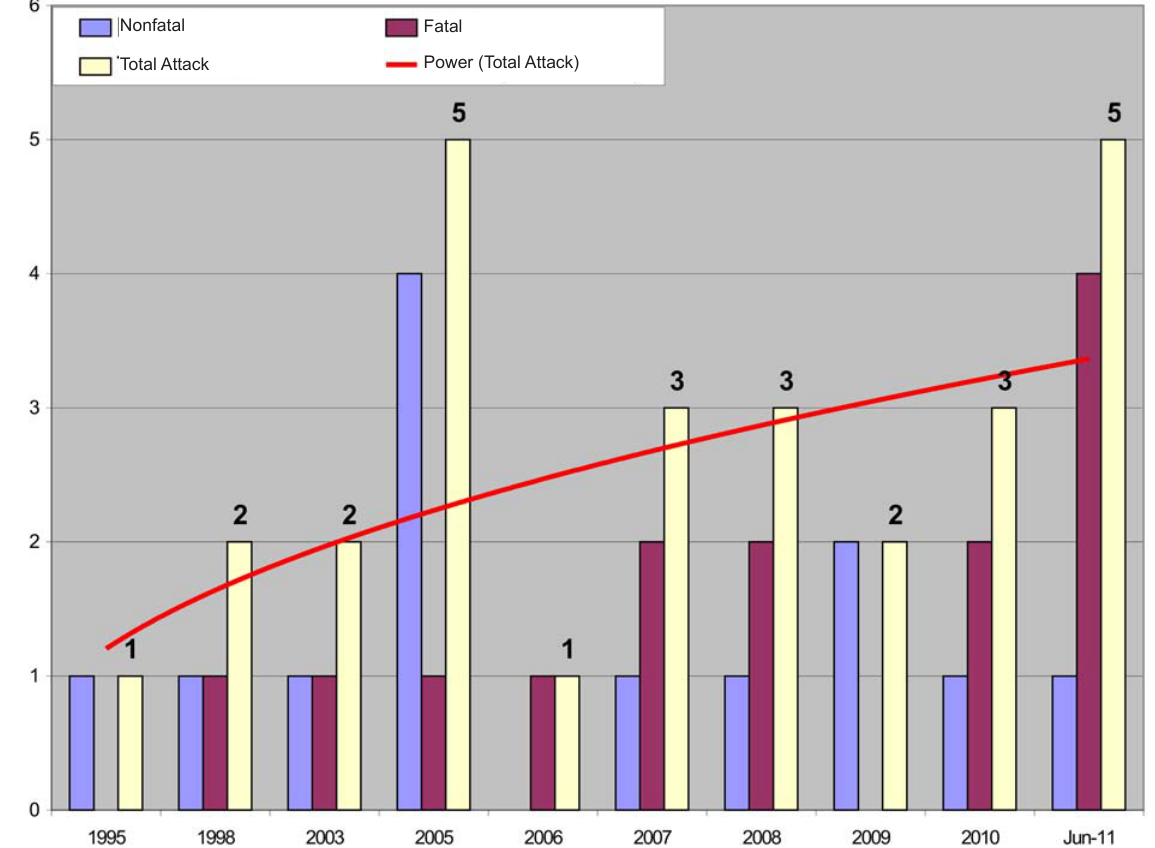
Figure 3. The trend in Mugger attacking humans has increased over the year, Vishvamitri River System, Gujarat,